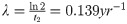
Failure curves for a conspiracy of No = 5000 over a 50 year period with exponential removal of conspirators with half-life t2 of 5 years (λ=ln2t2=0.139yr−1) with assumption of constant p and proportional change in p of p(t) = poeλt.